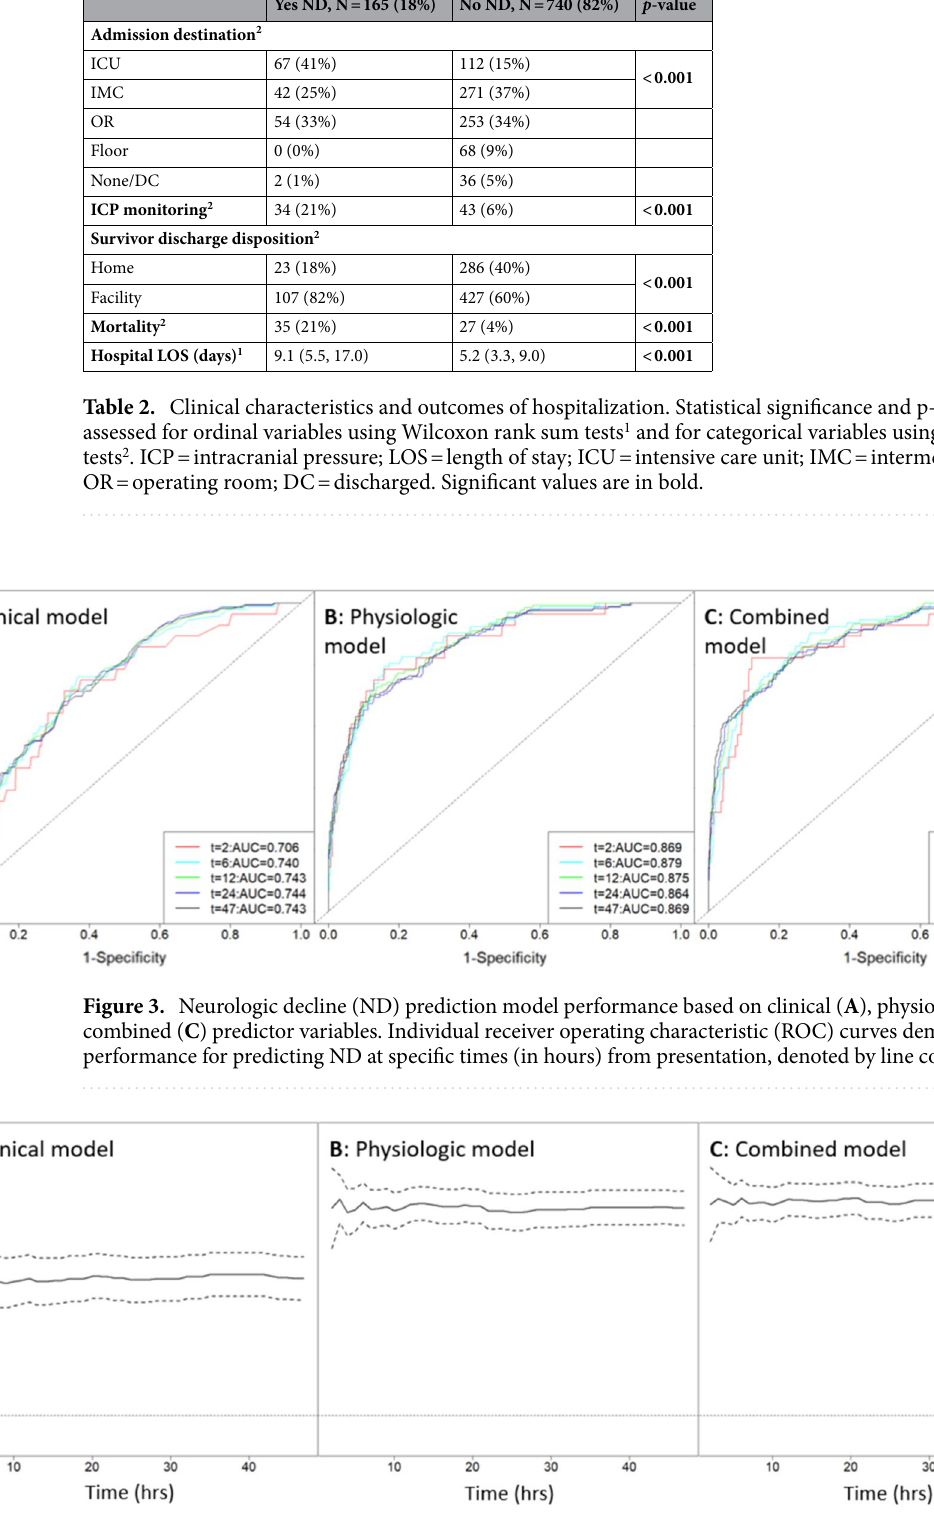
Figure 4. Time-dependent areas under the curve (AUC) of receiver operating characteristic (ROC) analysis (solid lines) displayed with 95% confidence intervals(CI, dotted lines) for ND prediction models based on clinical ( A ), physiologic ( B ), and combined ( C ) predictor variables. The time-independent concordance index (C-Index) for each model was 0.72 (95%CI: 0.69–0.76), 0.84 (95%CI: 0.81–0.87), and 0.85 (95%CI: 0.82–0.88),